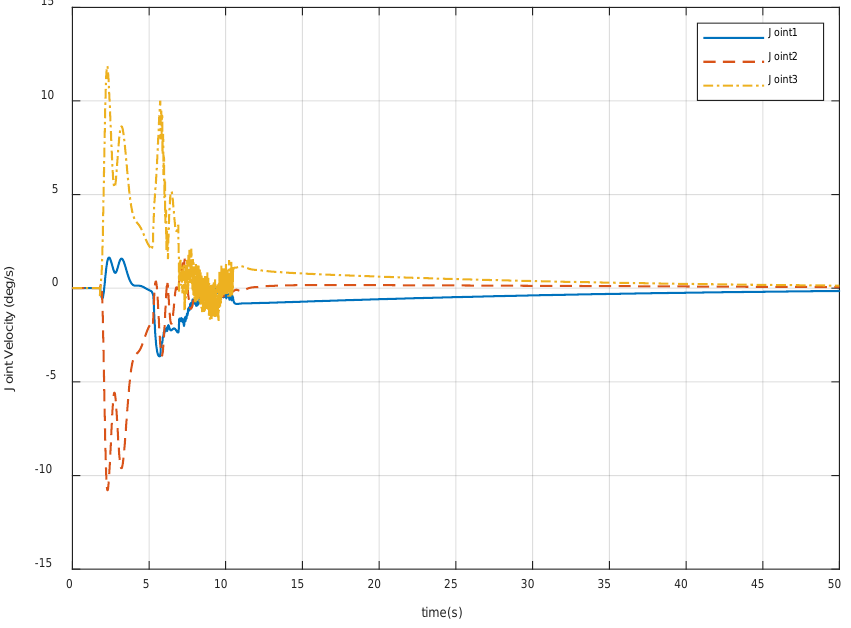
Figure 19. Variation of the manipulator joint velocities.